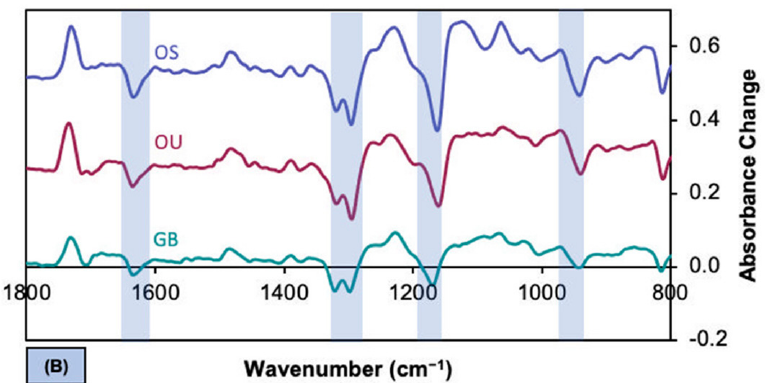
Figure 4. ( A , B ). Maximum difference in absorbance versus wavenumber (difference spectra) upon acetone evaporation ( A ) and upon polymerization ( B ) for OS, OU and GB. These were obtained by subtracting initial spectra from those at 5 min ( A ) and spectra at 5 min from those at 10 min ( B ), respectively. Blue bands indicate main acetone and monomer troughs in A and B arising, due to their loss upon evaporation and polymerization, respectively. Note—highlighted monomer troughs in B correspond with peaks in A due to solvent evaporation increasing monomer concentrations.